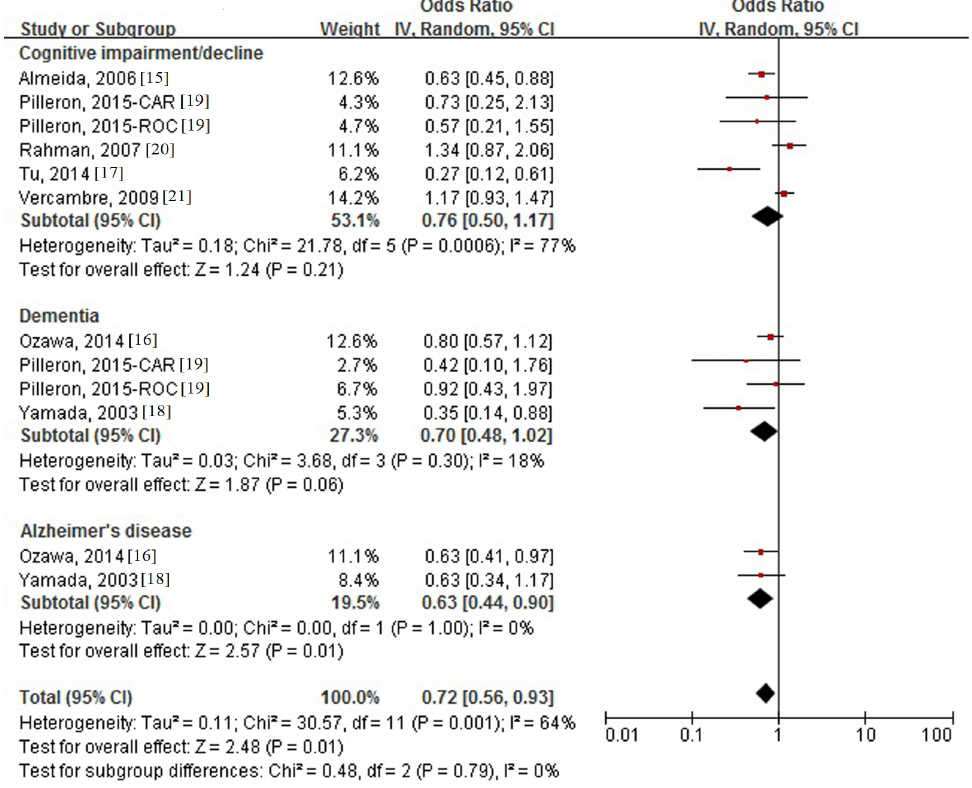
Figure 2. Forest plot of odds ratios (ORs) and 95% confidence intervals (CIs) for the association between milk intake and risk of cognitive disorders by type of